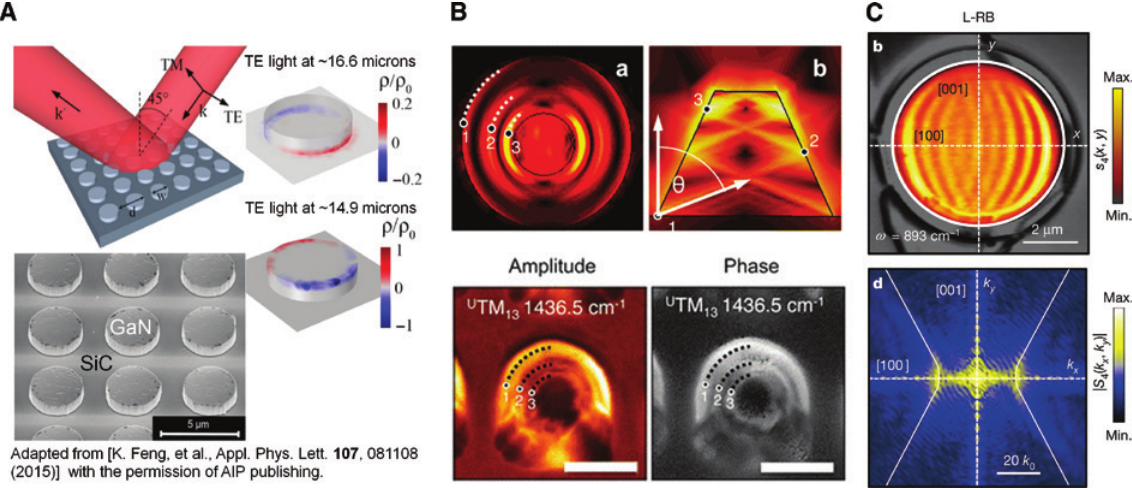
Figure 21: Experimentally observed particle PhPs. (A) LSPhPs [Type A ordinary (O) particle PhPs] in GaN microdisks resting on a SiC substrate. The two dipolar modes depicted are excited at different free-space wavelengths and have enhanced fields at the top or bottom of the microdisk, respectively. This is because of the